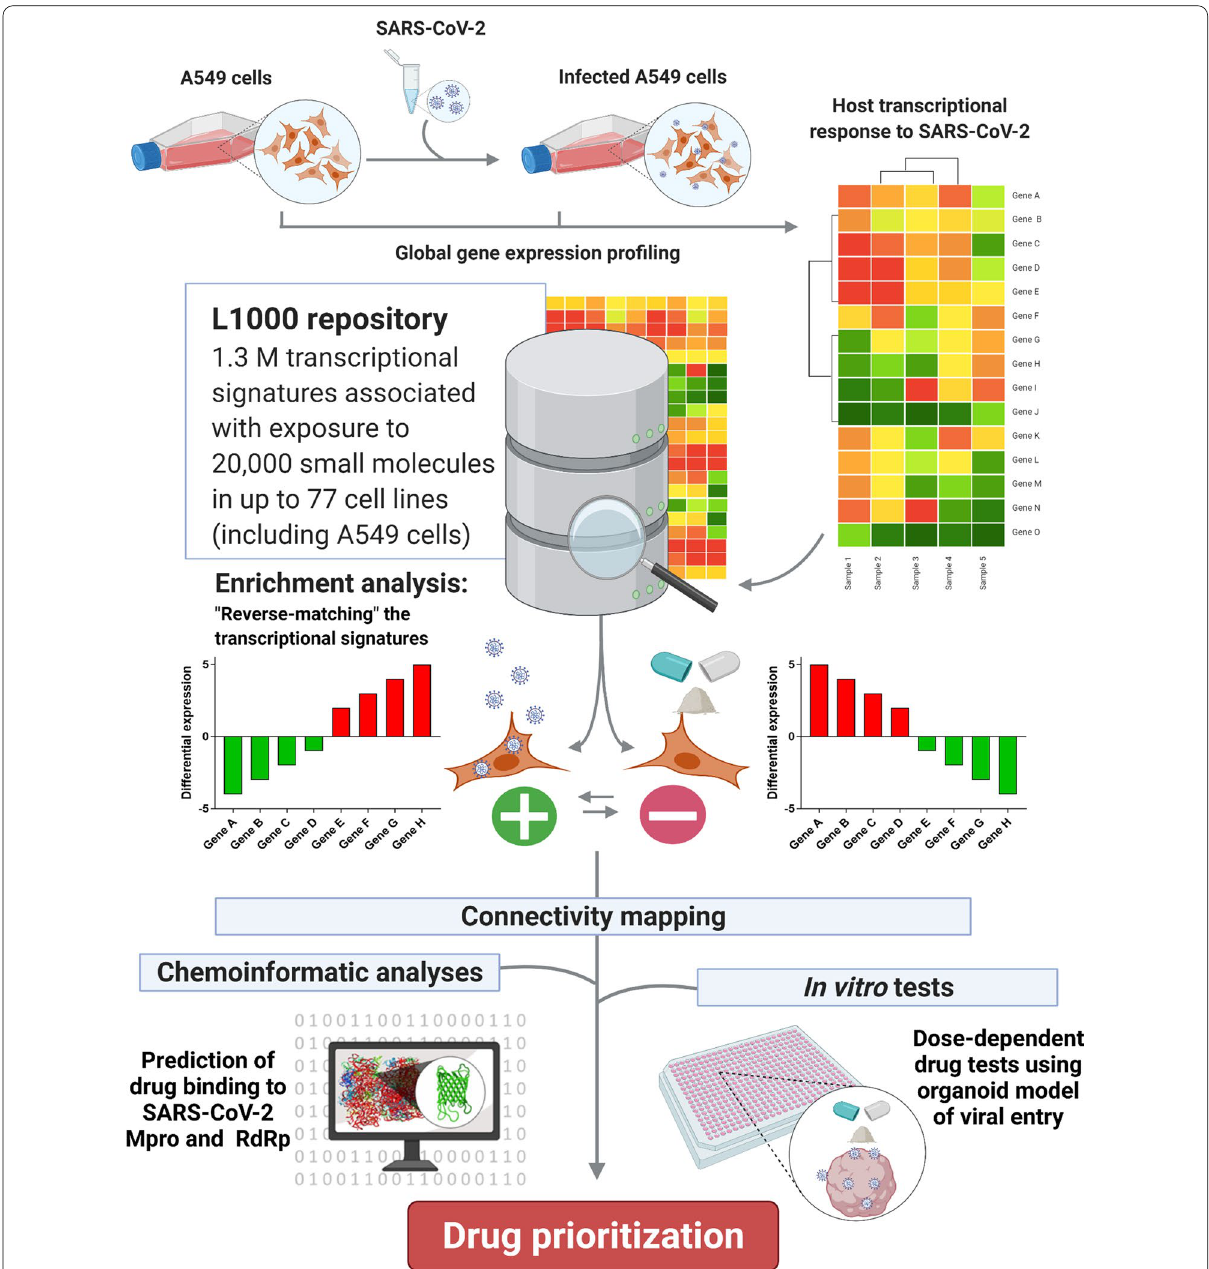
Fig. 1 Our analysis strategy. We used a connectivity mapping approach in combination with chemoinformatic analyses and in vitro tests using a lung organoid model, to investigate drugs with putative multimodal effects against SARS-CoV-2/COVID-19. Created with